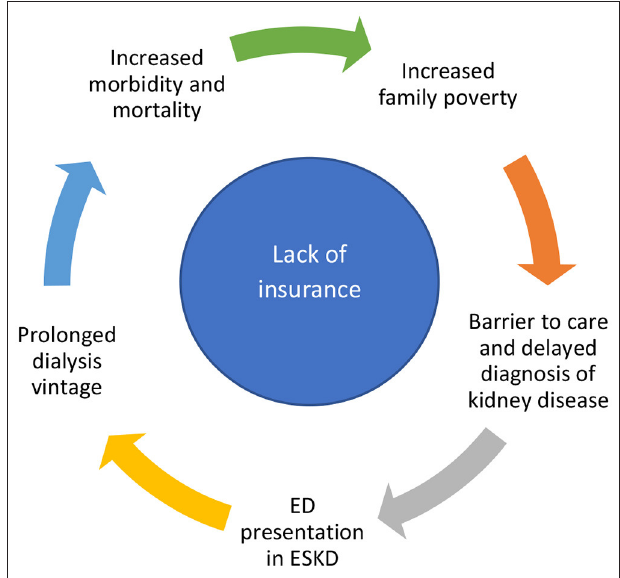
FIGURE 1 | The circle of burden of the uninsured with chronic kidney disease. ED, emergency department; ESKD, end stage kidney disease.